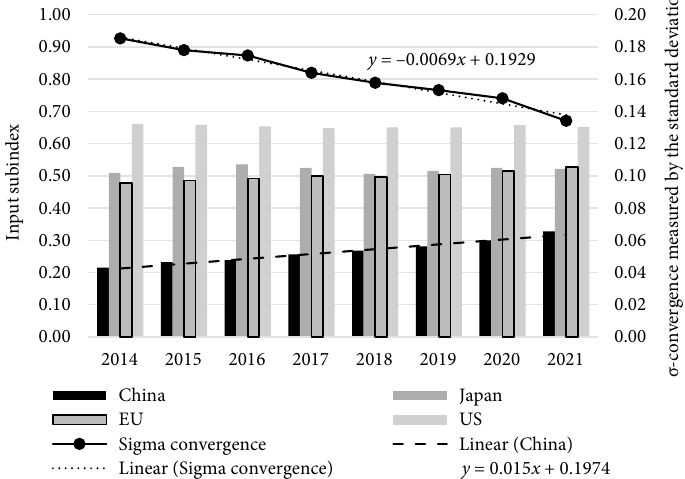
y = 0.015 x + 2021)Figure 4. The values of input subindexes for China and the Triad: the EU, Japan, and the US (source: author’s computations using data from European Innovation Scoreboard 2021)